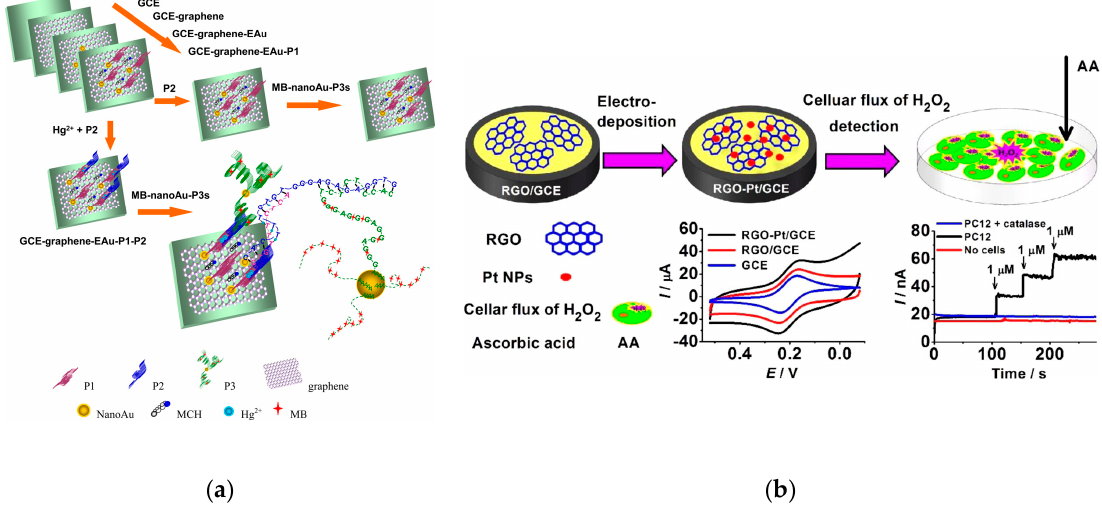
Figure 5. Application of GR and NPs in the fabrication of sensors. ( a ) The construction procedure of GR/AuNPs/GCE for detection of Hg 2+ . Reproduced with permission from reference [128]. Copyright American Chemical Society, 2015. ( b ) GO − Pt nanocomposite-modified GCE for detection of H 2 O 2 efflux from the cells stimulated with ascorbic acid. Reproduced with permission from reference [130]. Copyright American Chemical Society, 2014.